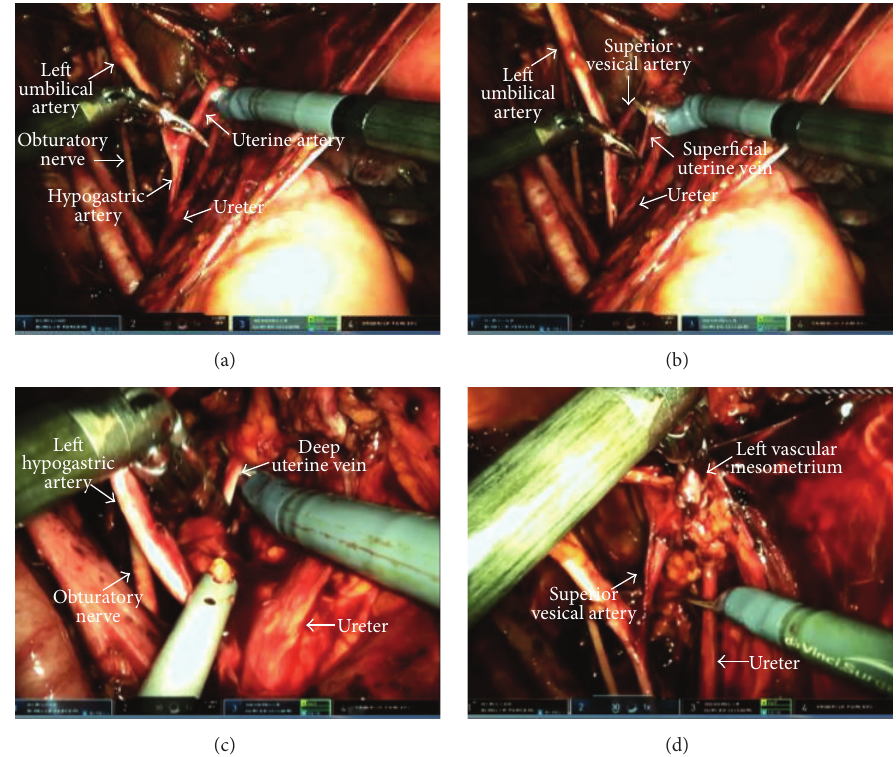
Figure 2: Resection of the lateral part of the vascular mesometrium (left side). (a) Resection of the uterine artery. (b) Resection of the superficial uterine vein. (c) Resection of the deep uterine vein. (d) The view of the resected mesometrial